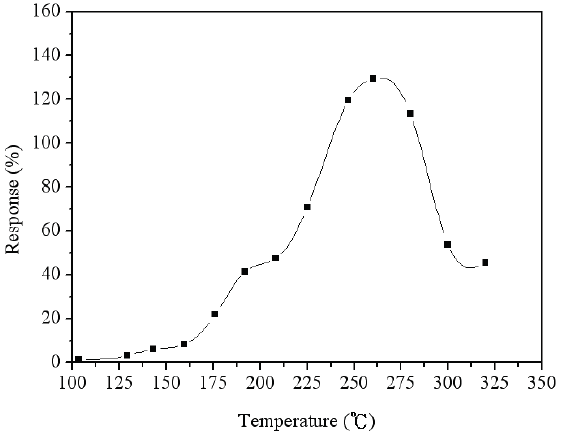
Figure 11. Response of the sensor at different